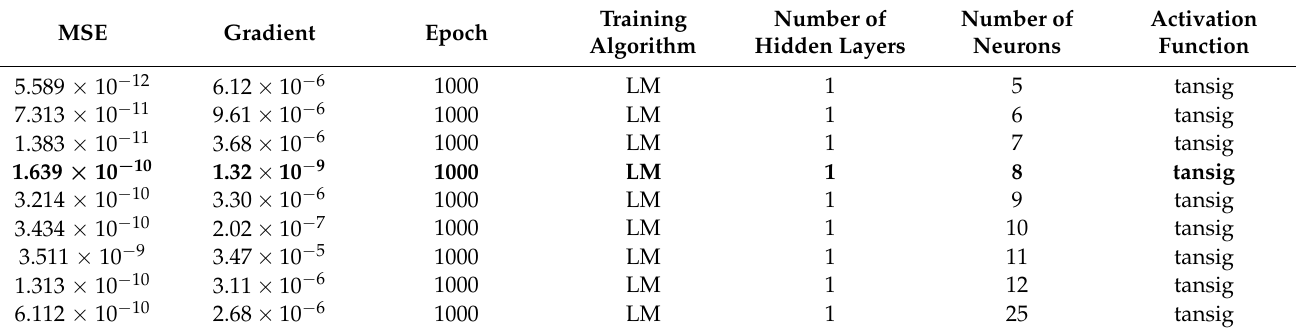
Table 1. Tests performed to obtain the optimized parameters of the ANNs. Training Number MSE Gradient Epoch Algorithm